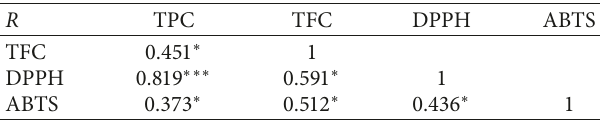
Figure 1: Effects of temperature and time on antioxidant activity (DPPH scavenging activity) of C. latifolia root extracts by SWE. Different letters indicate significant differences ( p < 0 . 05) within the same extraction temperature. Table 2: Correlations between TPC, TFC, ABTS, and DPPH of C. latifolia’s